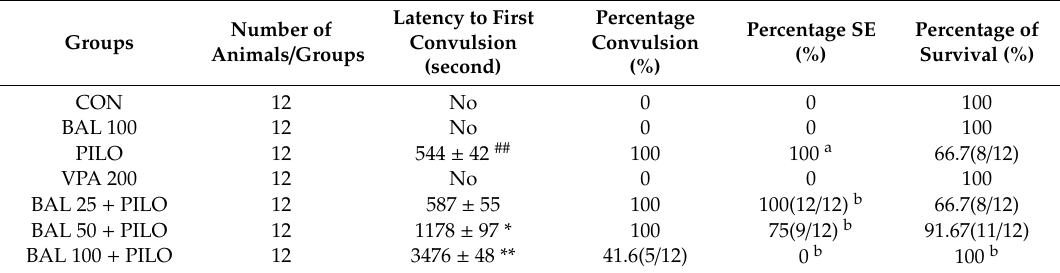
Table 1. E ff ect of baldrinal (BAL) on pilocarpine (PILO)-induced convulsions and lethality. Result for latency to the first convulsion was expressed as mean ± SEM ( n = 12). Data on survivors and the number of animals with with status epilepticus (SE) was calculated as percentages.